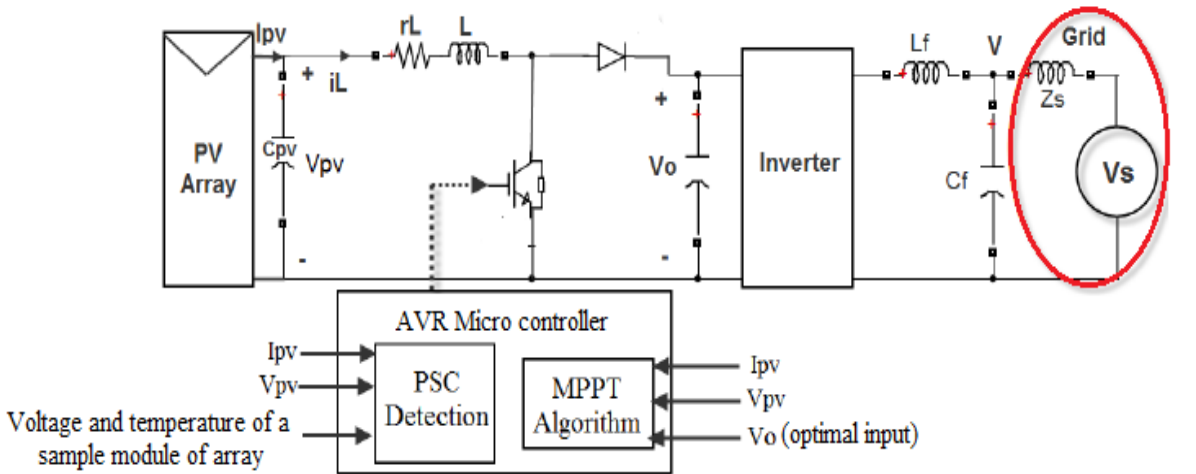
Figure 6. Overview of the structure of a two - stage grid - connected photovoltaic system. When using a boost converter to regulate a PV array, either an open or closed loop can be utilized. When operating at constant current and low irradiance, a photovoltaic array ’ s dynamic resistance is at its lowest. The stability and dynamic response are terrible. A single - loop PI voltage controller cannot close - loop control the array voltage because the